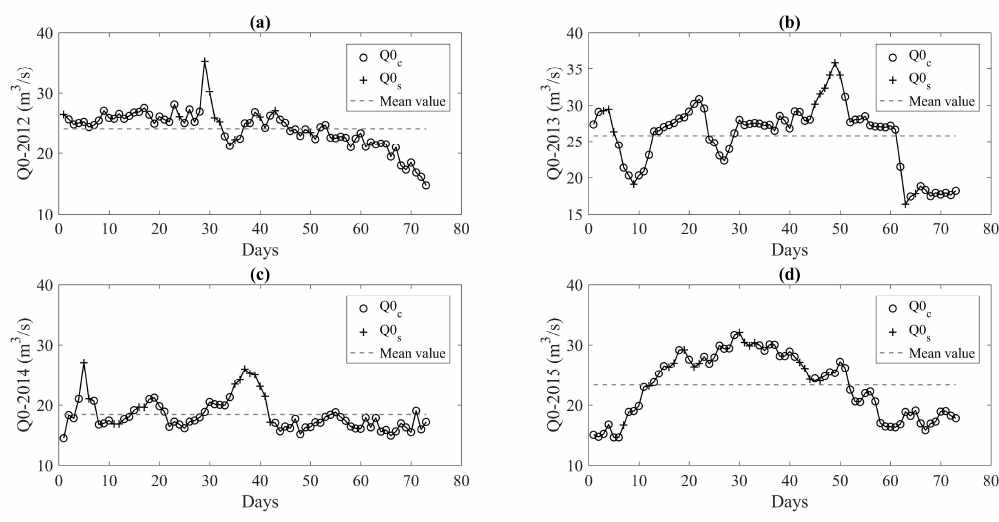
Figure 12. For every year: 2012 ( a ); 2013 ( b ), 2014 ( c ) and 2015 ( d ), the values of discharge ( Q0 ) calculated at WL OUT_0. calculated at WL OUT_0.